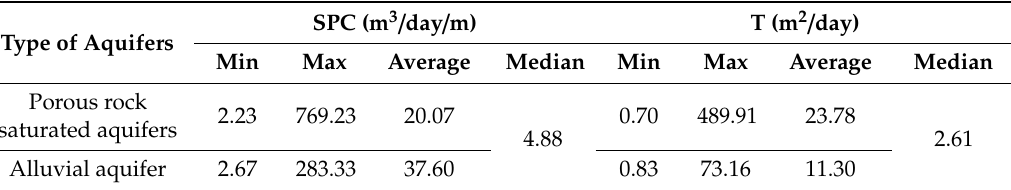
Table 2. The results of the pumping test of wells in the